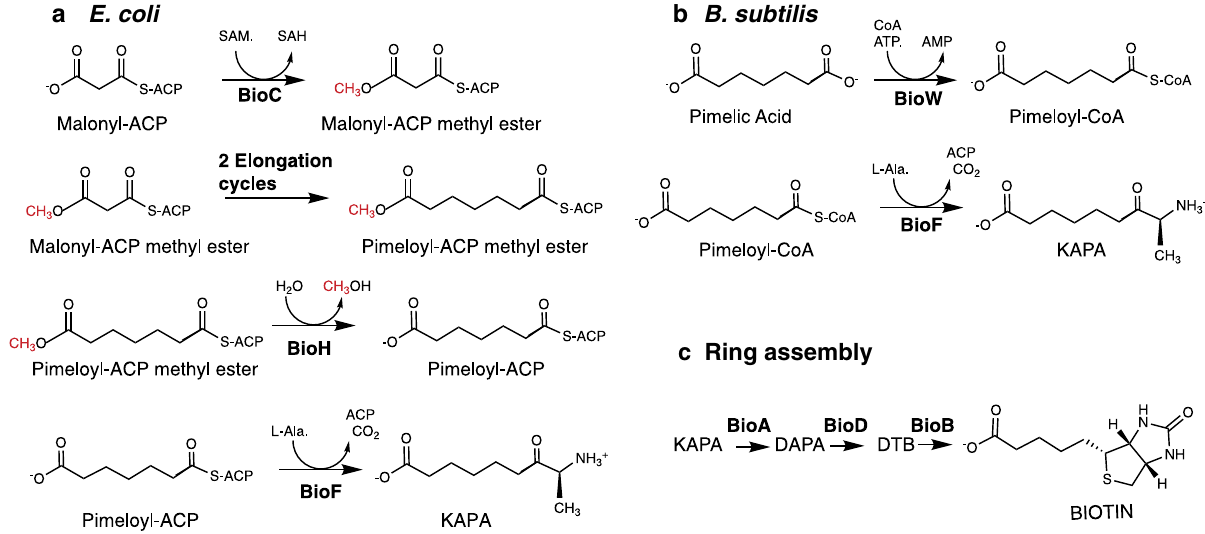
Fig. 1 The known pathways of pimeloyl moiety synthesis. a In E. coli and (as inferred from genome analyses) many other bacteria, malonyl-ACP methyl ester replaces the usual acetyl primer of fatty-acid synthesis. After two cycles of chain elongation the methyl group is removed by BioH to give the BioF substrate, pimeloyl-ACP. (Red letters denote the methyl group donated by S-adenosyl- L -methionine (SAM) and subsequently released as methanol. b In B. subtilis the pimelate chain is also assembled by fatty-acid synthesis, but unlike E. coli , the pathway proceeds through a free pimelic acid intermediate that requires activation by BioW. c Schematic of the late steps in biotin synthesis. Systematic chemical nomenclature for KAPA is 7-keto-8-aminopelargomic acid whereas DAPA is 7,8-diaminononanoic acid. DTB is